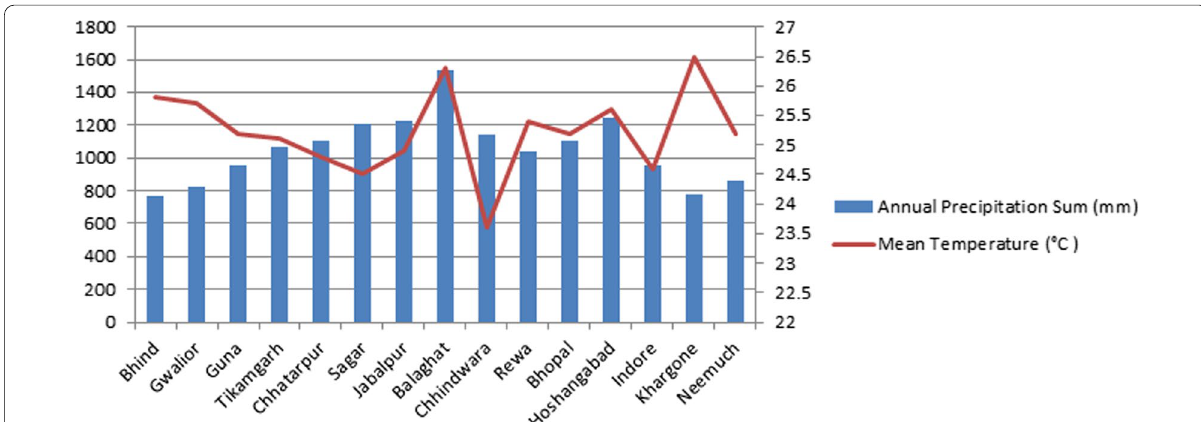
Fig. 3 District-wise annual mean precipitation and temperature of Madhya Pradesh state in central India during 1901–2016 (115 years). The blue bars depict the mean annual rainfall (mm) of the district, whereas the red line shows the mean annual temperature (°C) of the district. The maximum mean annual rainfall is recorded in Balaghat district, whereas the maximum mean temperature is recorded in Khargone